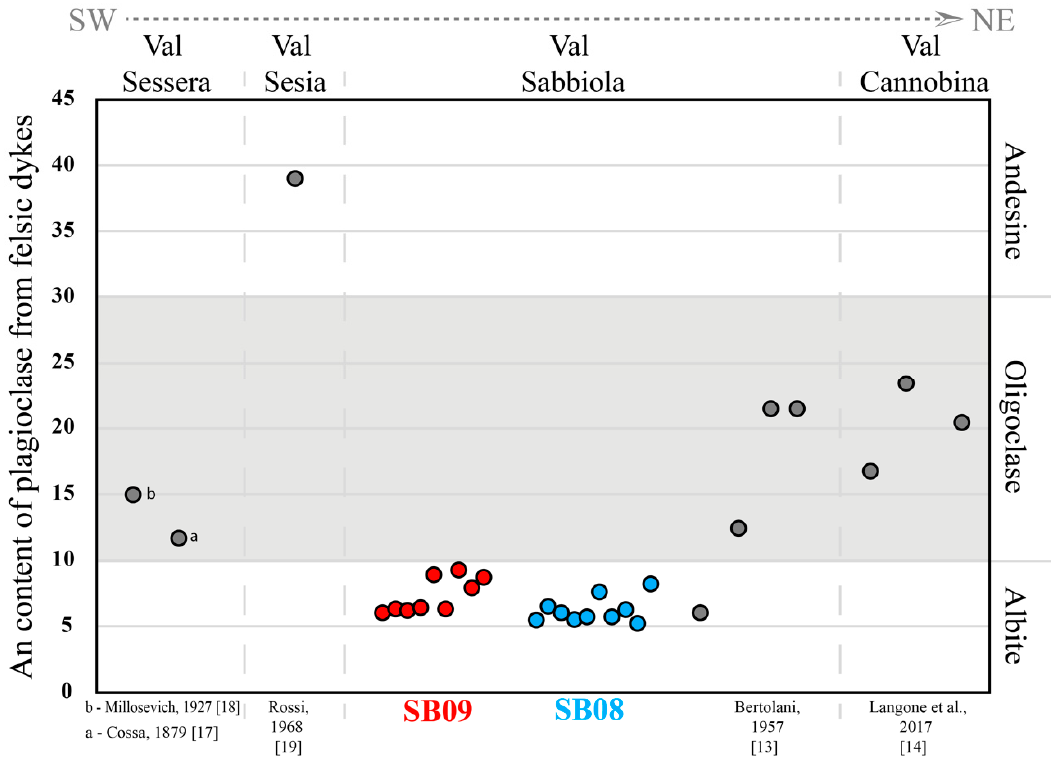
Figure 5. Anorthite content (An mol%) of plagioclase within corundum-bearing felsic dykes reported in different valleys of the of the IVZ, arranged from SW to NE. The red and blue circles show the composition of plagioclases for SB09 and SB08 dykes, respectively. The grey circles show the composition of plagioclases for other felsic dykes recognized in IVZ.